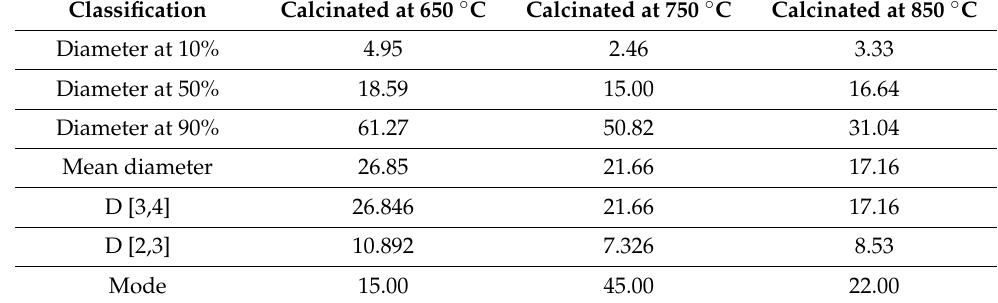
Table 2. The distribution of particles of samples at different calcination temperatures (units: µ m).